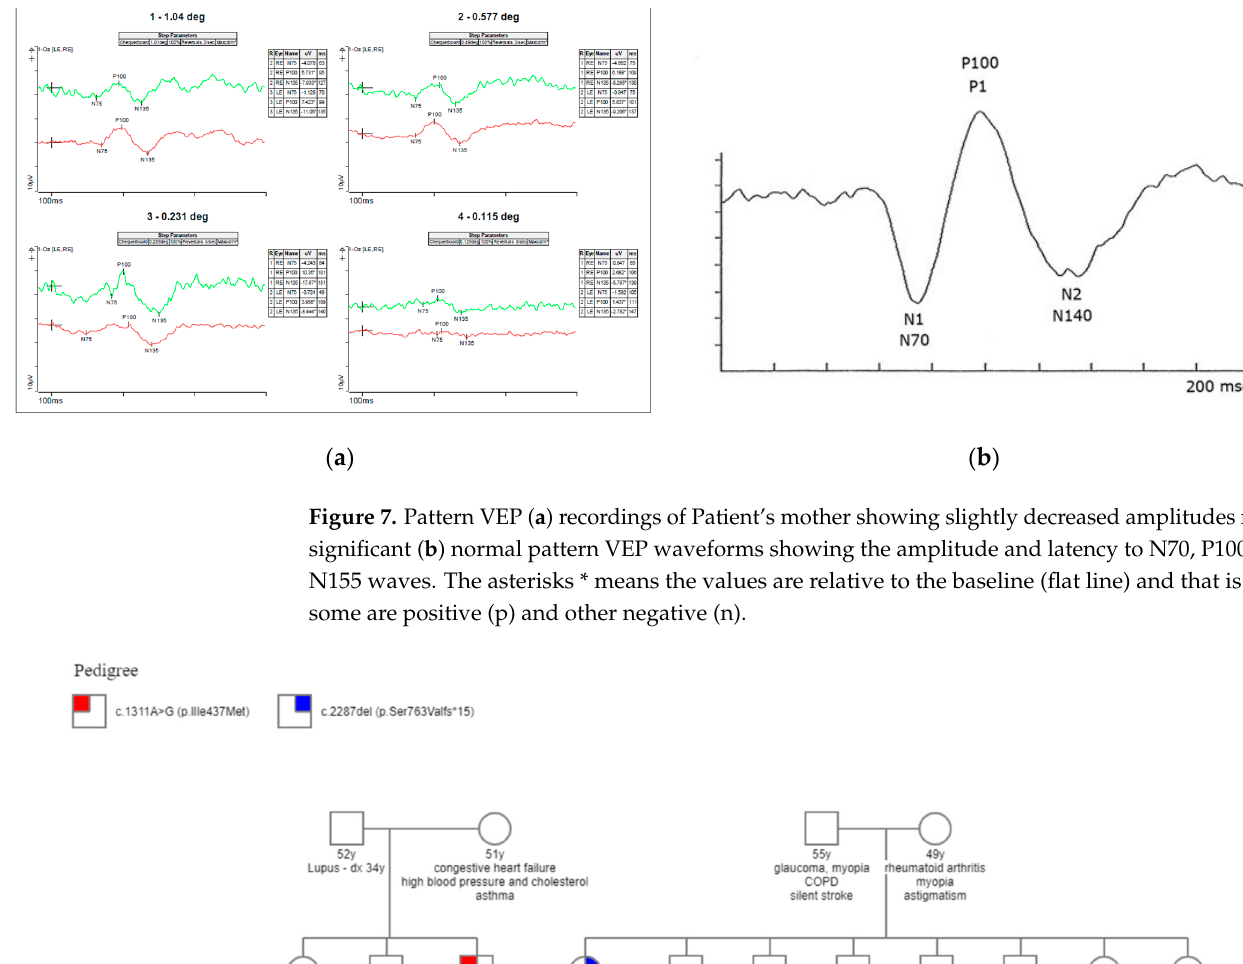
Figure 7. Pattern VEP ( a ) recordings of Patient’s mother showing slightly decreased amplitudes more significant ( b ) normal pattern VEP waveforms showing the amplitude and latency to N70, P100 and N155 waves. The asterisks * means the values are relative to the baseline (flat line) and that is why some are positive (p) and other negative (n).